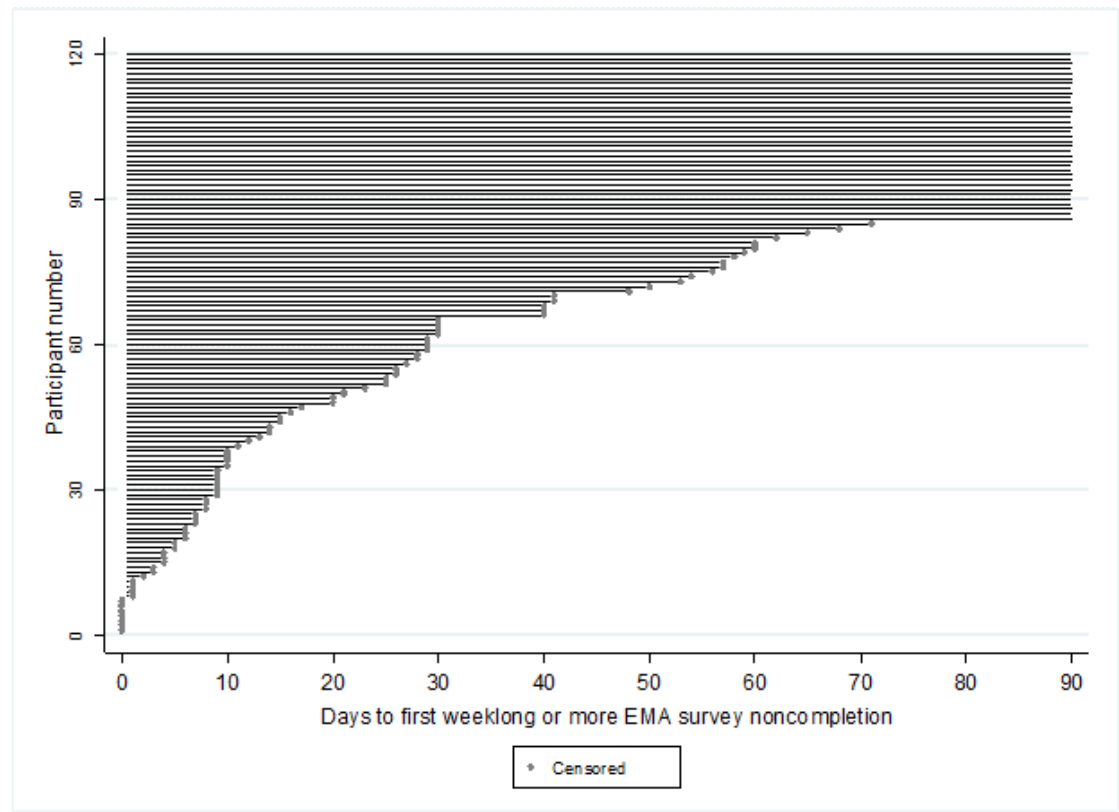
Figure 1. Event plot censoring the follow-up days that transpired before participants’ first experience of a weeklong or more ecological momentary